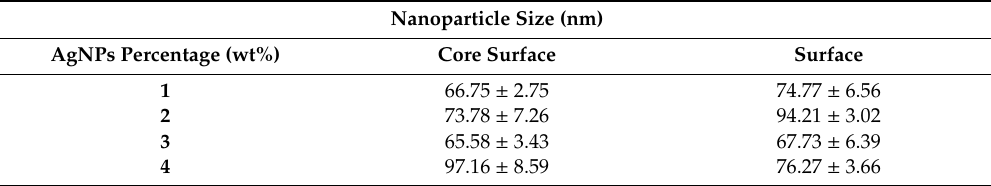
Table 3. Nanoparticle sizes of AgNPs for di ff erent weight percentages.